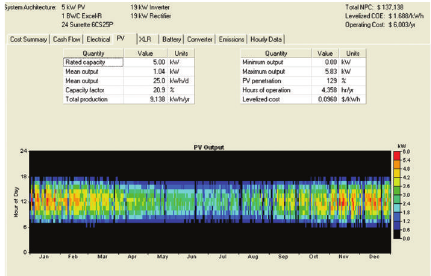
Figure 12: PV output summary.